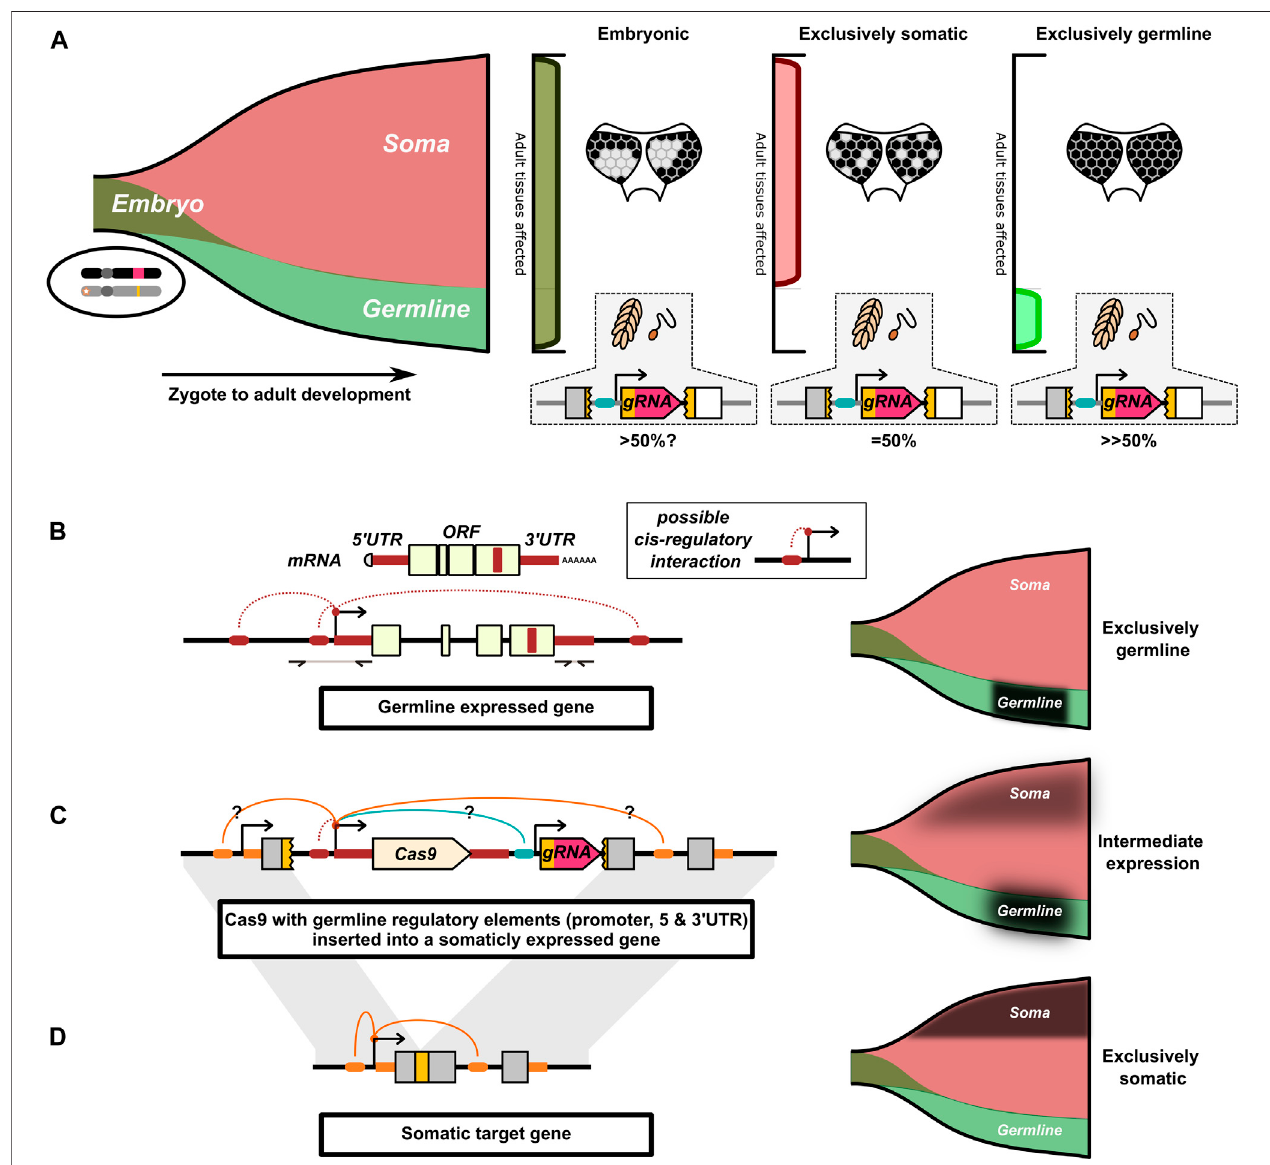
FIGURE 3 | Illustration of the interaction of spatial and temporal restricted drive expression. (A) Drive activity in the early embryo can simultaneously affect cells of the somatic and germline lineages. Drive activity later in development can independently affect the germline and somatic cells. The funnel represents the cells that compose an individual as it develops from a zygote to an adult (left-to-right). Early in development, cells are simultaneously part of both the germline and somatic cell lineages. Only later in development do the germline and somatic cell lineages diverge. The pattern of somatic mosaicism in adult tissue can under certain circumstancesbeindicative ofthetimingofcutting,here indicatedbydifferentpatternsofloss ofpigment intheeye.Inthese cases,thelaterindevelopmentthesomatic gene is disrupted, the more fi ne-grained the mosaic pattern. (B) Cas9 can be engineered to mimic the expression of endogenous germline restricted genes. This is commonly approached byuse of the promoter, 5 ′ and 3 ′ UTR of agermline restricted gene. The 5 ′ and 3 ′ UTR can be identi fi ed from mRNA transcripts. Generally, afew Kb of sequence upstream of the 5 ′ UTR are taken to capture the putative promoter. We have indicated additional speculative cis-regulatory interactions important for germline restricted expression that are not captured by this approach. (C) The Cas9 gene with the germline regulatory elements is inserted into the target gene ’ s locus. Cas9 ’ s expression may be affected by cis-regulatory interactions with the target gene and with other drive components. We speculate that this may result in the Cas9 gene taking on an intermediate expression pattern resulting from the combination of different cis-regulatory interactions. (D) The target gene commonly has a somatic expression pattern that may not be conducive to homing. For (B – D), the proposed expression pattern of the respective allele is indicated by a black overlay on the